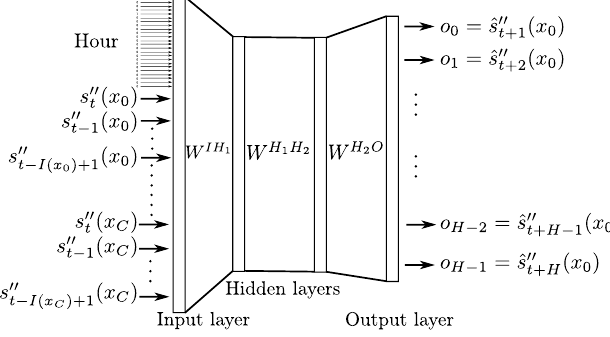
Figure 2. Artificial neural network (ANN) topology for time series